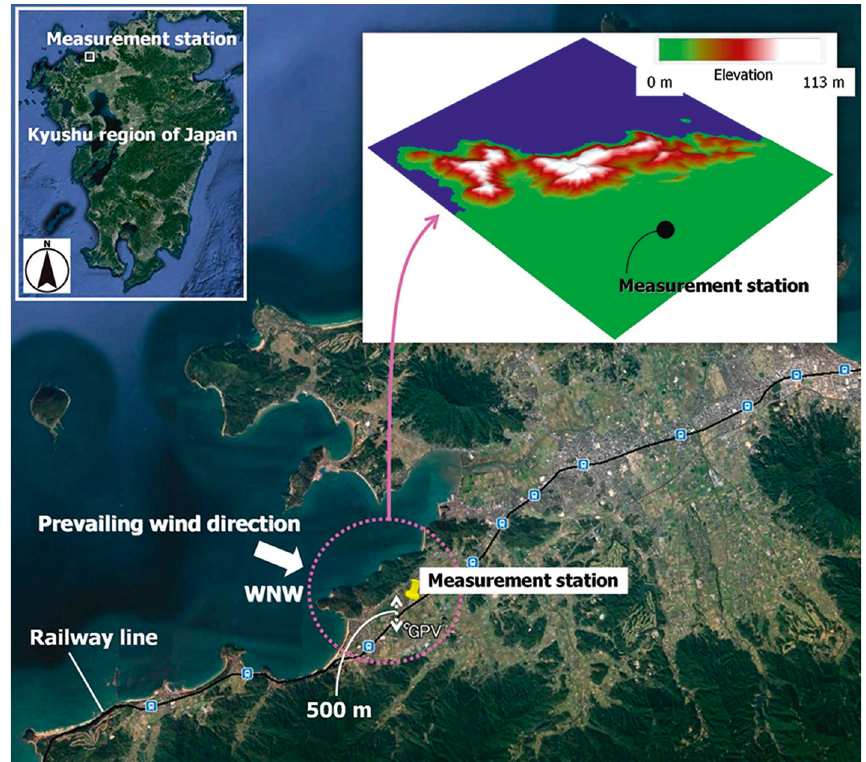
Figure 1: Locations of the railway line and observation mast and evaluation points of weather GPV data existing around the observation mast.